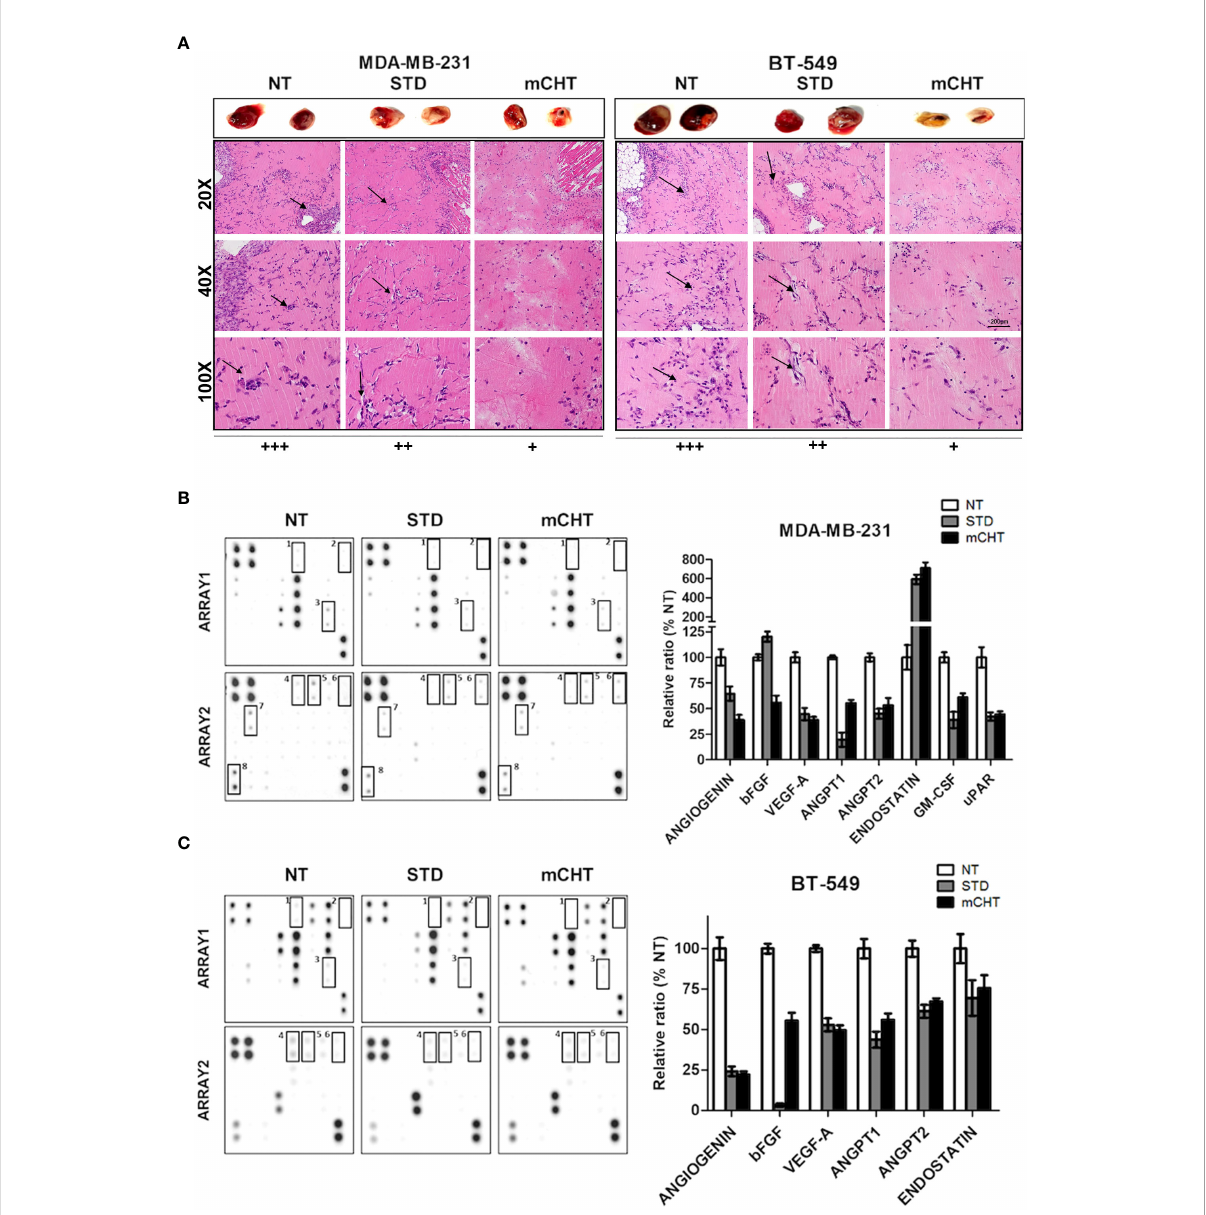
FIGURE 10 Conditioned medium from TNBC cells treated with 5-FU+VNR under mCHT schedule inhibits angiogenesis in vivo and modulate the expression of angiogenesis-related protein. MDA-MB-231 and BT-549 cells ’ supernatant collected at the end of a 96h-treatment with the respective IC 50s of 5-FU+VNR under the mCHT or STD schedule and from untreated cells was added into Matrigel and injected subcutaneously into C57/BL6 mice. Four days after the injection, mice were sacri fi ced, and plug vascularization was evaluated. (A) , top : two representative images of the Matrigel plugs for each treatment are shown. bottom : Hematoxylin-eosin staining was used to identify neovessel formation in the Matrigel plugs. Neovessels were evaluated by two different pathologists and scored as +++, ++ or + depending on their frequency. 20X, 40X and 100X, representative images are shown. Arrows indicate in fi ltrating endothelial cells. (B, C) Analysis of the expression pro fi les of proteins involved in the angiogenesis process. Proteome Array membranes were incubated with c-NT, c-STD and c-mCHT derived from both TNBC cell lines overnight at 4°C as described in the Materials and Methods section. Control proteins are spotted in two opposite corners of the arrays. The experiment was repeated using duplicate conditioned media of the TNBC cells. Modulated proteins in treated vs control cells are highlighted with squares and indicated by numbers. Duplicate spots for each protein are present on the array membrane. On the right of the array membranes: modulated protein quanti fi ed as a percentage of untreated